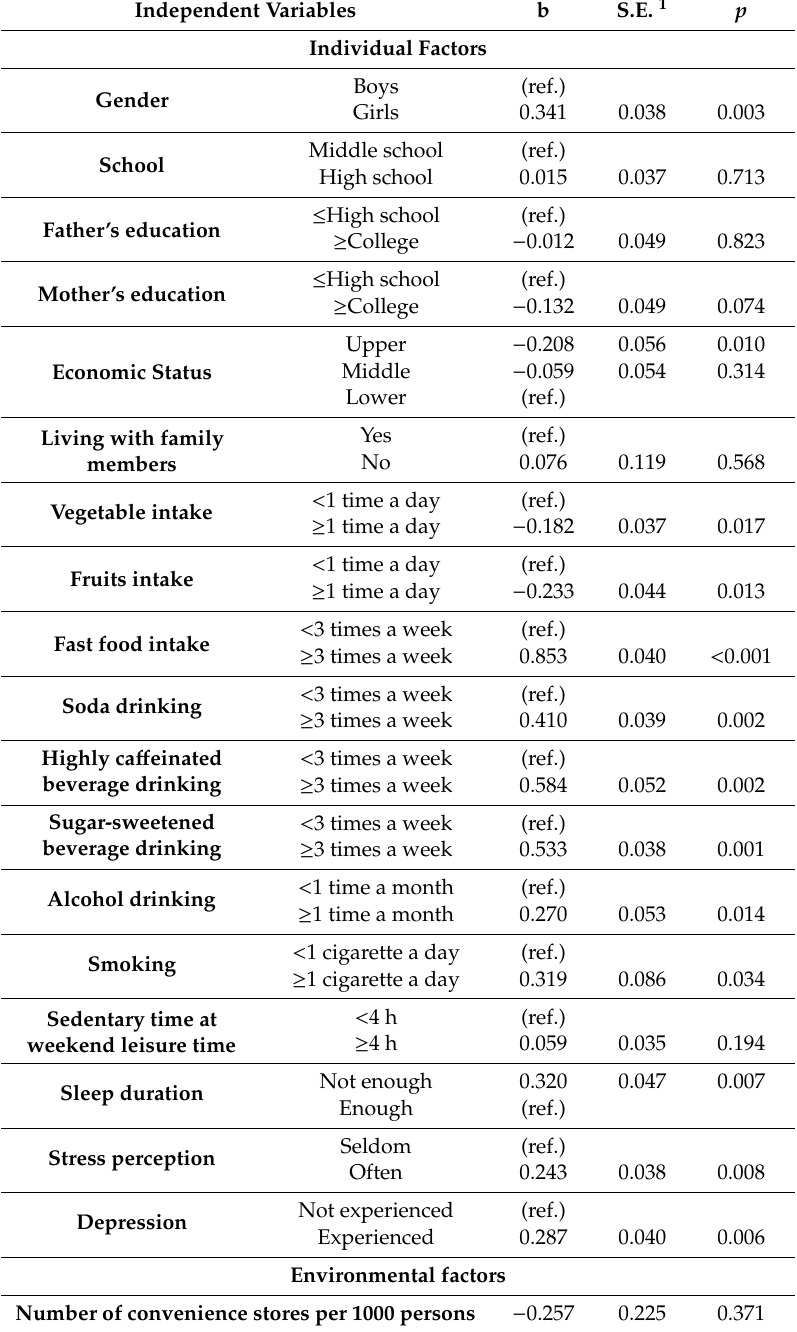
Table 3. Results of Multilevel Analysis for the Factors Influencing Substitution of Meals with Convenience Store